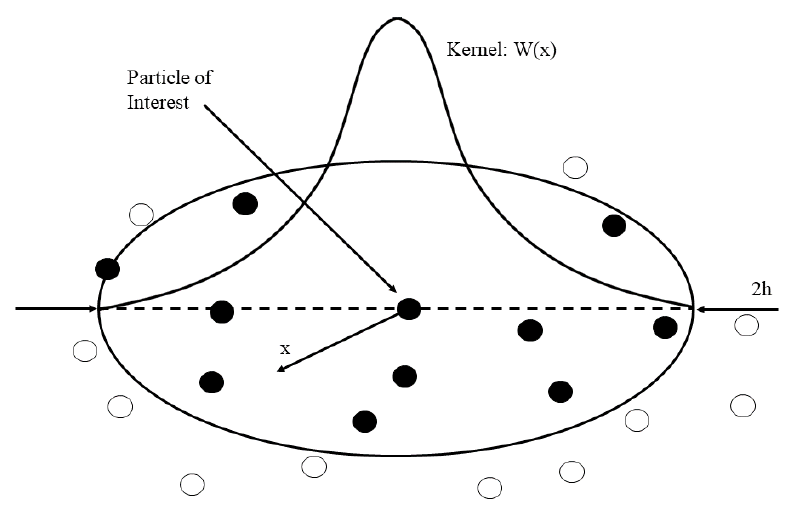
Figure 3. Visualization of the Cubic Spline Kernel